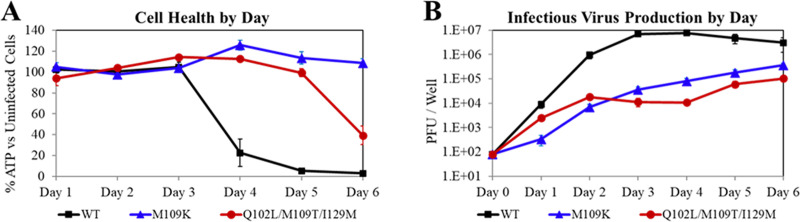
Growth kinetics of EDP-938 resistance mutants vs. wild-type (WT) virus.Viral Fitness analysis. (A) Cell viability compared to uninfected cells quantified by cellular ATP levels. (B) Plaque forming units (PFU) produced per well per day. Data are mean ± SEM, N = 3–7 for all runs.